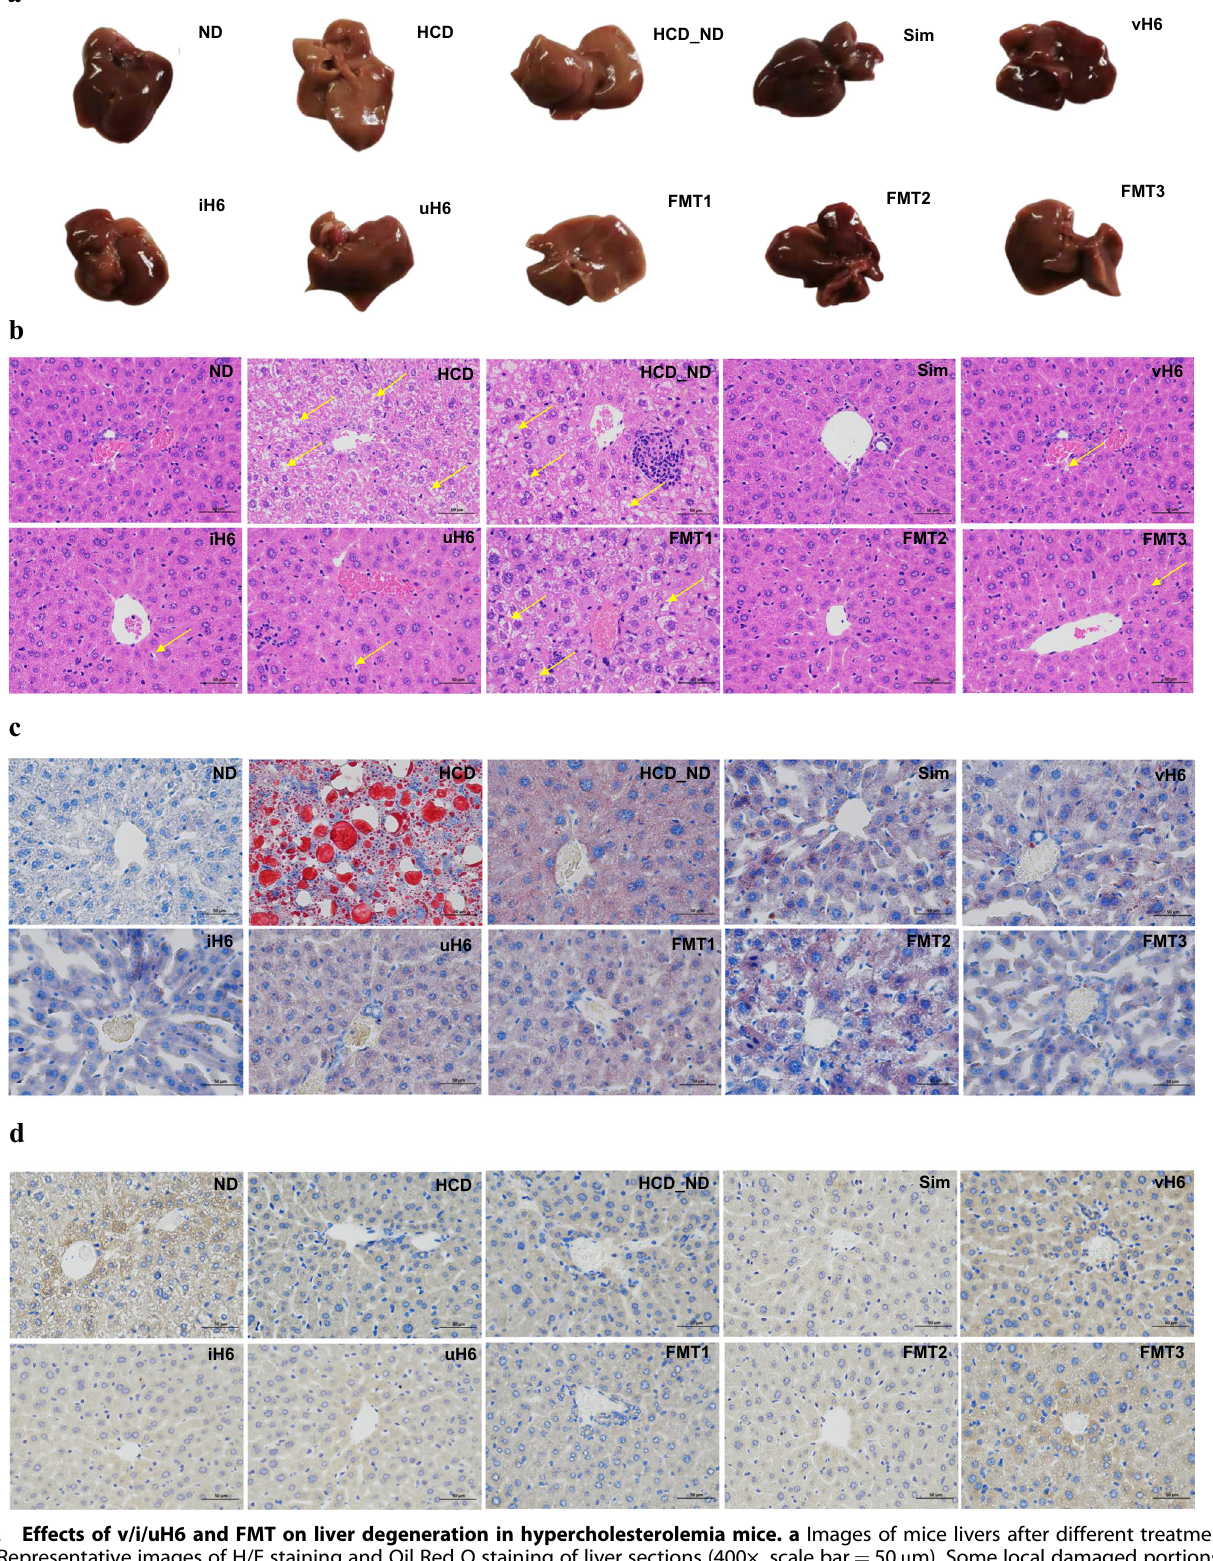
Fig. 2 Effects of v/i/uH6 and FMT on liver degeneration in hypercholesterolemia mice. a Images of mice livers after different treatments. b , c Representative images of H/E staining and Oil Red O staining of liver sections (400×, scale bar = 50 μ m). Some local damaged portions of hepatocyte are indicated by yellow arrows in H/E staining. d Representative images of immuno fl uorescent staining of liver sections using anti- UCP1 (400×, scale bar = 50 μ m). HCD_ND refers to the group of hypercholesterolemia model mice; v/i/uH6 refers to viable (vH6), heat- inactivated (iH6), and ultrasonically-lysed (uH6) bacteria cells; FMT1/2/3 refers to using feces from HCD_ND, Sim and vH6 groups,